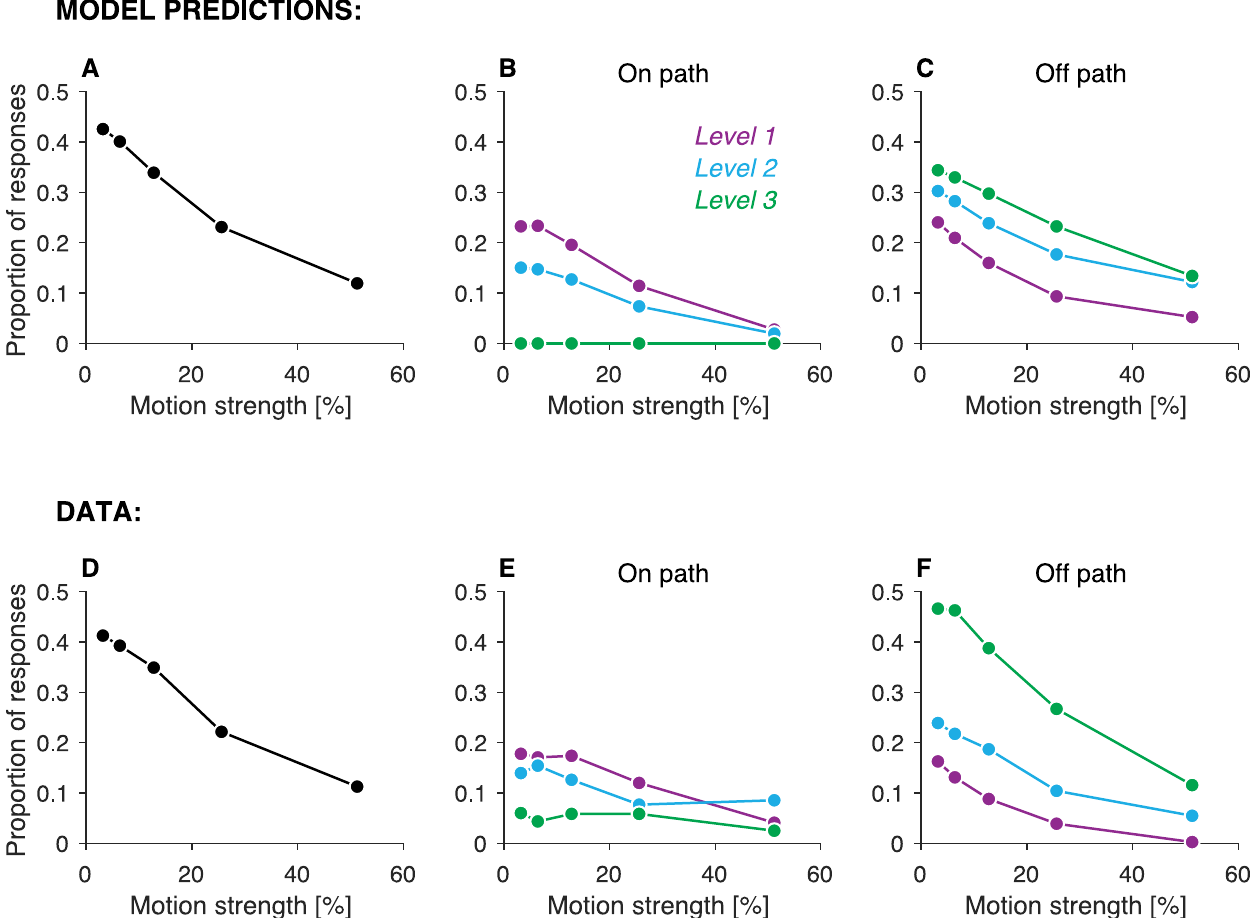
Fig 9. Motion strength and tree level influence which node is blamed for an error. Panels A-C show the predictions of the heuristic model and panels D-F correspond to the behavioral data. (A) Proportion of errors for which the blame was assigned to a node with the motion strength indicated in the abscissa, given that a node with that motion strength was in the error-path. Note that proportions do not need to add to 1 since the error-path can contain up to three different values of motion strength. (B) Proportion of errors that were followed by an on-path query to a node of level ℓ , given that level ℓ of the error-path had the motion strength indicated in the abscissa. For example, if the root node had the weakest possible motion strength, the probability that an on-path query is made at that node is * 0.23. (C) Proportion of errors that were followed by an off-path query from a node of level ℓ , given that level ℓ of the error- path had the motion strength indicated in the abscissa. For example, if the root (level 1) node had the weakest possible motion strength, there is a * 0.25 chance that the root node is blamed for the error and an off-path query is made to its child that was not on the error path. Proportions were first calculated per participant and then averaged across